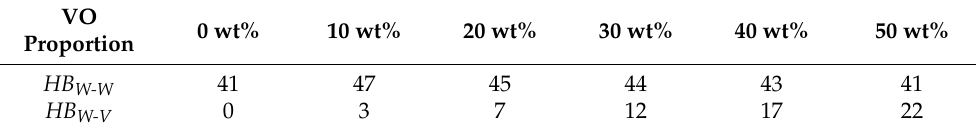
Table 5. The average number of different types of hydrogen bonds at 1 wt% water content.